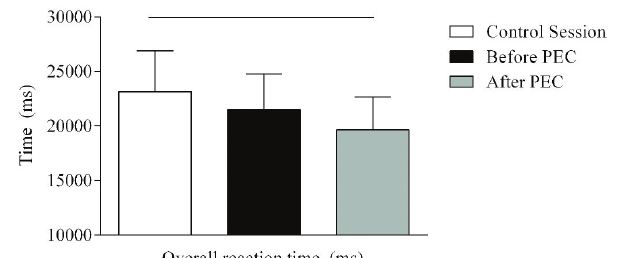
Figure 3. Results for overall reaction time in Stroop Test, for control session (white bar), before PEC (black bar) and after PEC (gray bar). Condition main effect was found (p = 0.000; F = 95.394; d = 2.763, extremely large ES). Only Stroop Test outcomes obtained before the PEC were